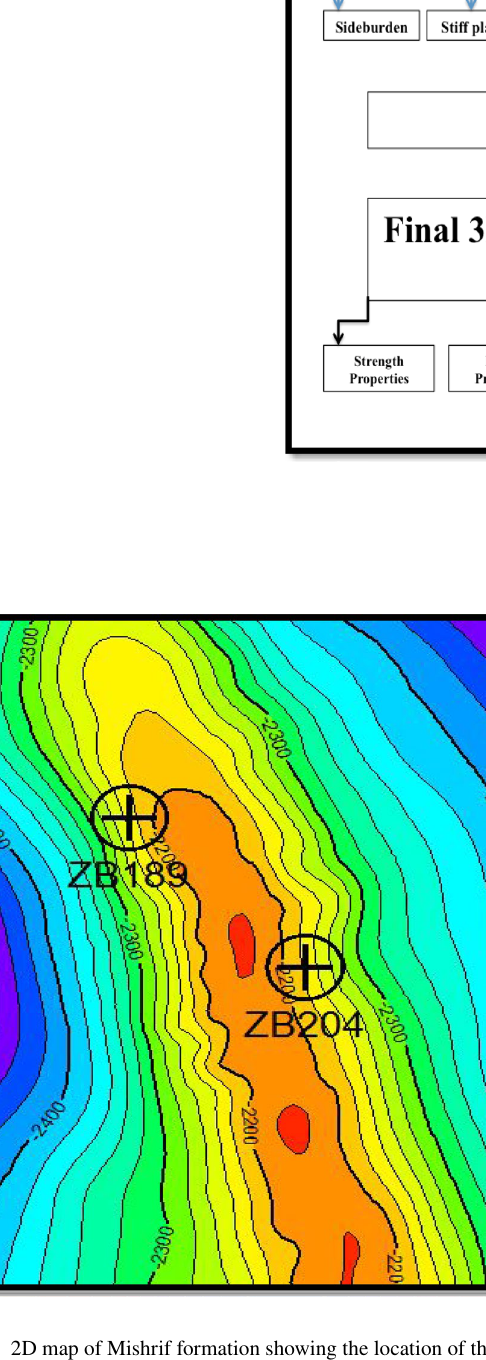
Fig. 5 2D map of Mishrif formation showing the location of the